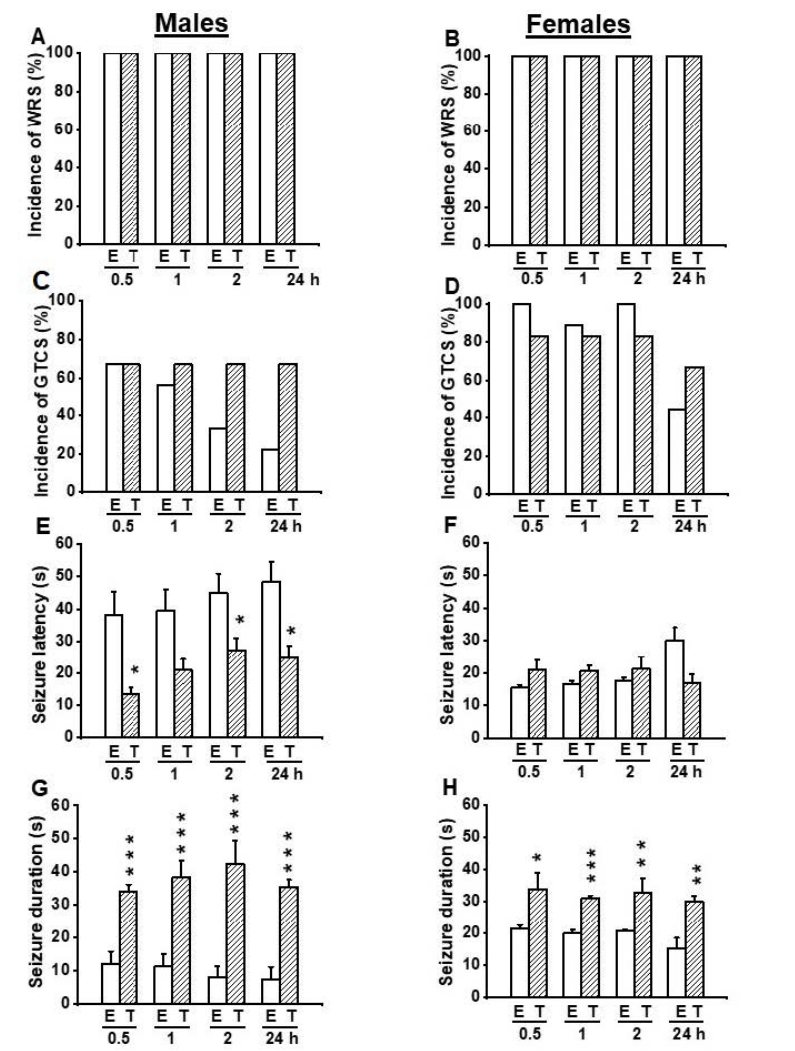
Figure 5. Effects of acute treatment with EACT (E) and T16Ainh-A01 (T), a potent activator and blocker of TMEM16A channels, respectively. The effects of EACT ( n = 9) and T16Ainh-A01 ( n = 6) on acoustically evoked seizures were evaluated at the dose of 10 mg/kg and at various posttreatment time points (0.5, 1 h, 2 h, and 24 h) in adult male and female GEPR-3s. Data were compared to determine the extent to which T16Ain-A01 treatment reverses the antiseizure effects seen in the EACT-treated group. ( A ) The incidence of the occurrence of WRSs was similar in both the EACT- treated and the T16Ainh-A01-treated groups in males. ( B ) Likewise, the incidence of the occurrence of WRSs was similar in both the EACT-treated group and T16Ainh-A01-treated group in females. ( C ) T16Ainh-A01 treatment reversed the reduced incidence of GTCSs seen in the EACT-treated group in males, but this effect did not reach statistical significance. ( D ) Similarly, T16Ainh-A01 treatment did alter the effects of EACT on the incidence of the occurrence of WRSs in female GEPR-3s. ( E ) T16Ainh-A01 treatment significantly reversed the effect of EACT treatment on the seizure latency in males. ( F ) In females, T16Ainh-01 also significantly reversed the effect of EACT on the seizure latency. ( G ) T16Ainh-A01 treatment significantly reversed the effect of EACT treatment on the seizure duration in males. ( H ) In females, T16Ainh-01 also significantly reversed the effect of EACT on the seizure duration. Data from the incidence of the occurrence of WRSs and GTCSs were represented as a mean percentage (%), and Fisher Exact test was used for analysis. Data from the seizure latency and duration were presented as mean ± S.E.M., and one-way ANOVA followed by Bonferroni correction was used for analysis. Opened and filled bar graphs represent EACT-treated GEPR-3s (E) and T16Ainh-A01-treated GEPR-3s (T). * p < 0.05, ** p < 0.01, *** p <